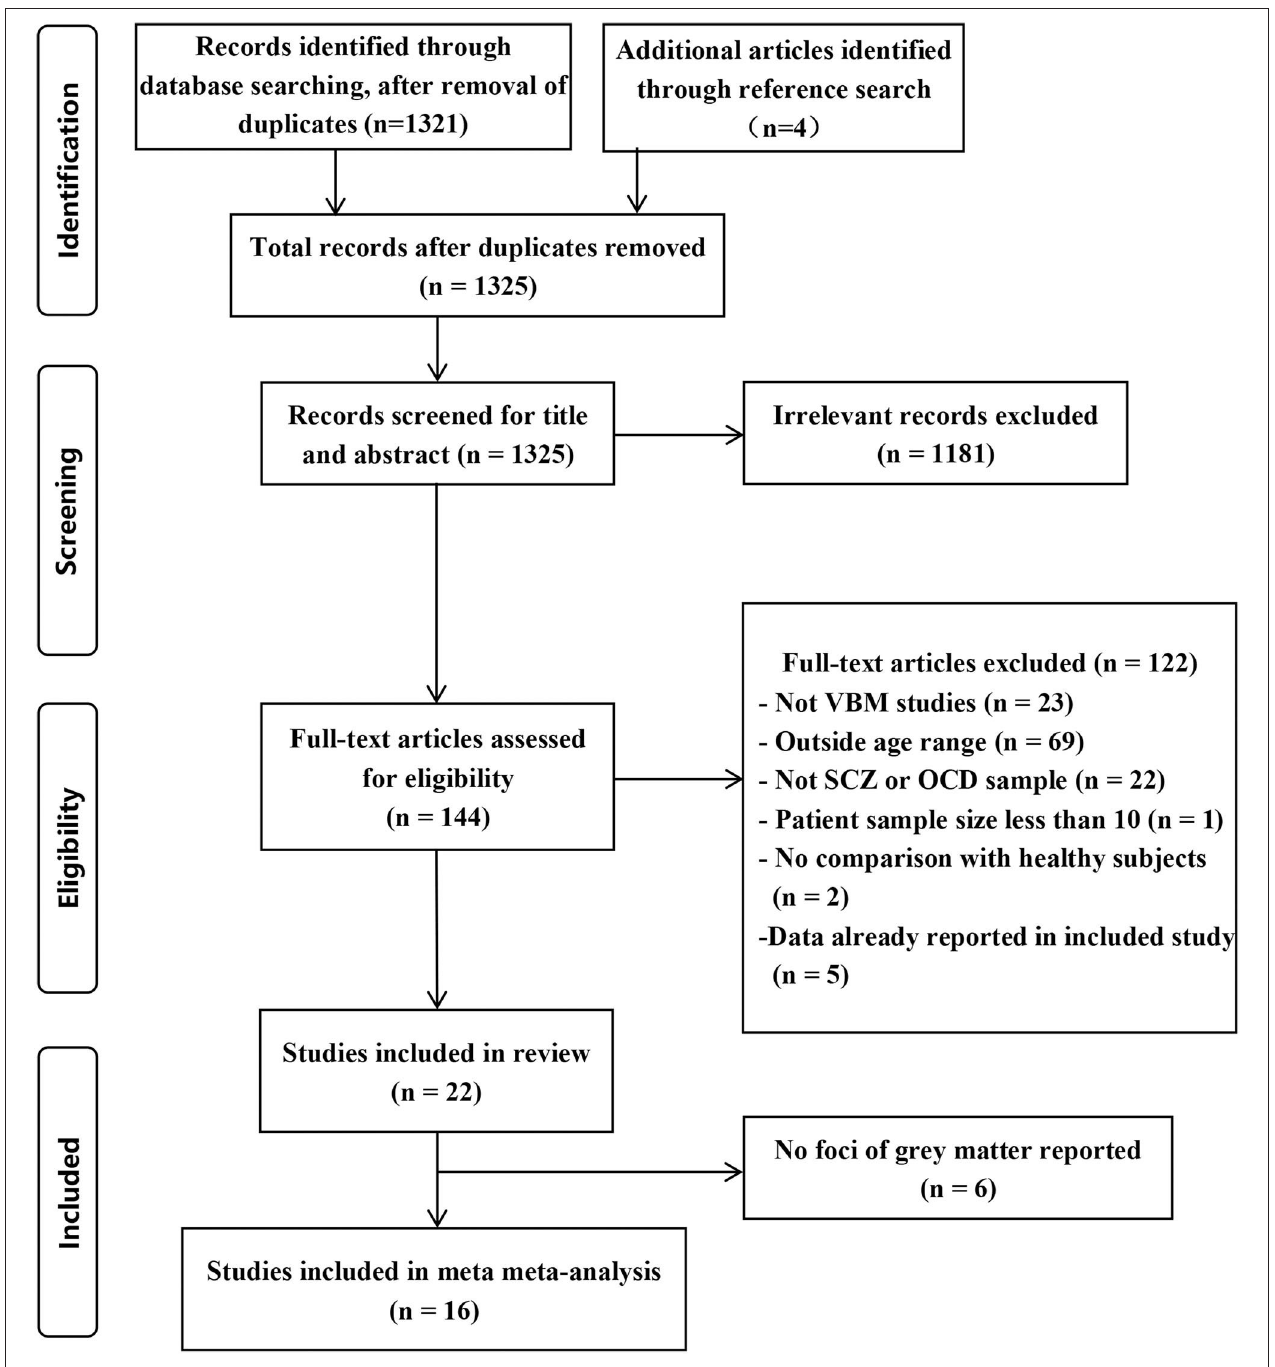
FIGURE 1 | Flowchart of the selection